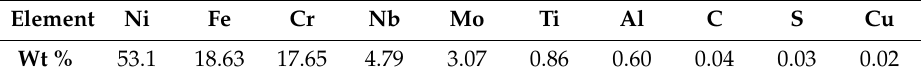
Table 1. Chemical composition of selective laser melted (SLM) IN718 alloy.